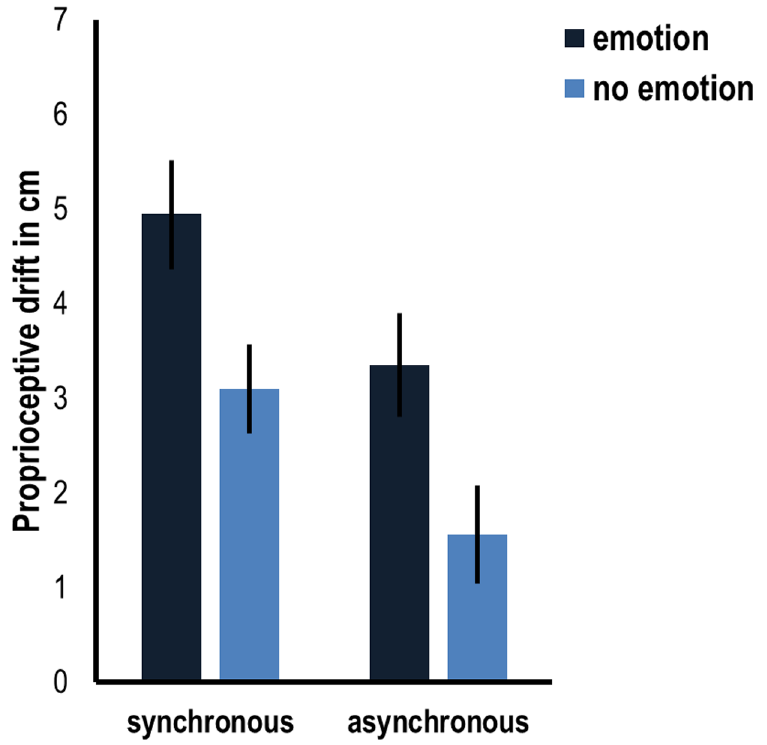
Fig 3. Average proprioceptive drift in cm for the data pooled into emotion (angry and happy vocal) and no emotion (no sound and non-vocal sounds) with synchronous or asynchronous stroking. Error bars indicatestandard